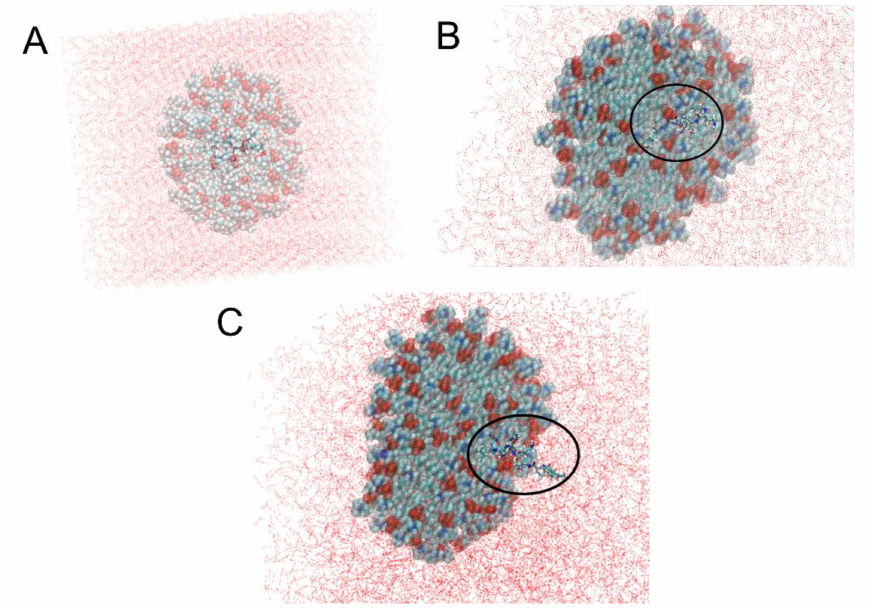
Figure 3. CST interaction with dodecylphosphocholine (DPC) micelle through 10 ns ( A ) DPC Micelle with CST at 0 ns. ( B ) DPC micelle with CST at 2 ns ( C ) DPC micelle with CST at 7 ns. Black circle highlights the